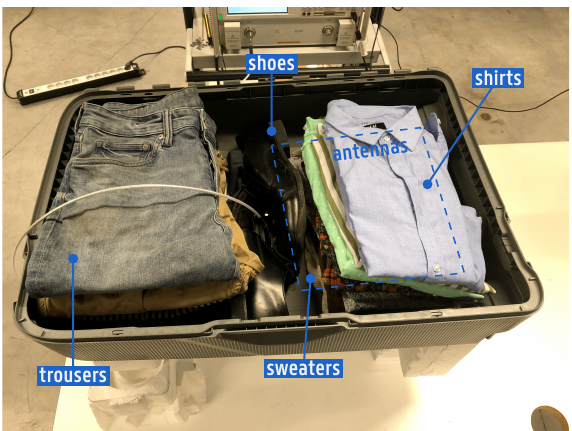
Figure 12. Suitcase filled with a standard set of clothes, comprised of trousers, shoes, sweaters, and shirts. This setup was used for determining the influence of the suitcase’s contents on the antennas’ reflection coefficient.